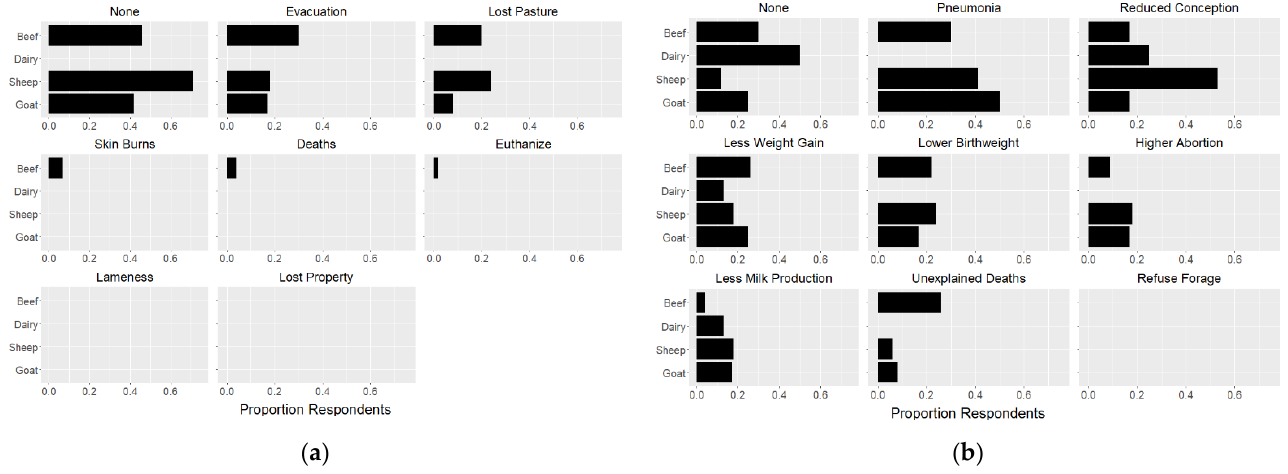
Figure 2. Proportion of survey respondents reporting they experienced or observed ( a ) direct and/or ( b ) indirect effects of 2020 wildfires by livestock type.